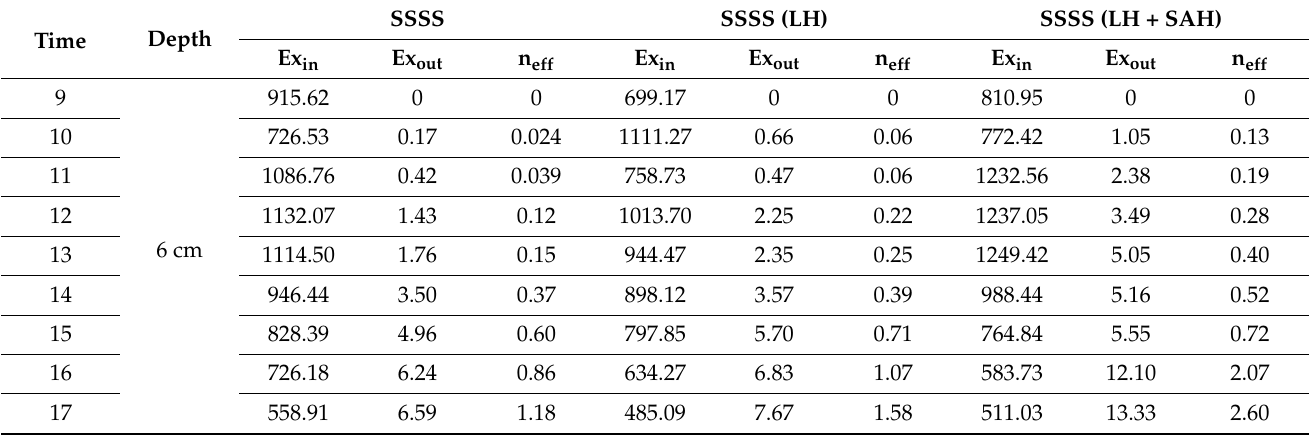
Table 4. Exergy analysis of SSSS, SSSS (LH) and SSSS (LH + SAH) at the depth of 6 cm.